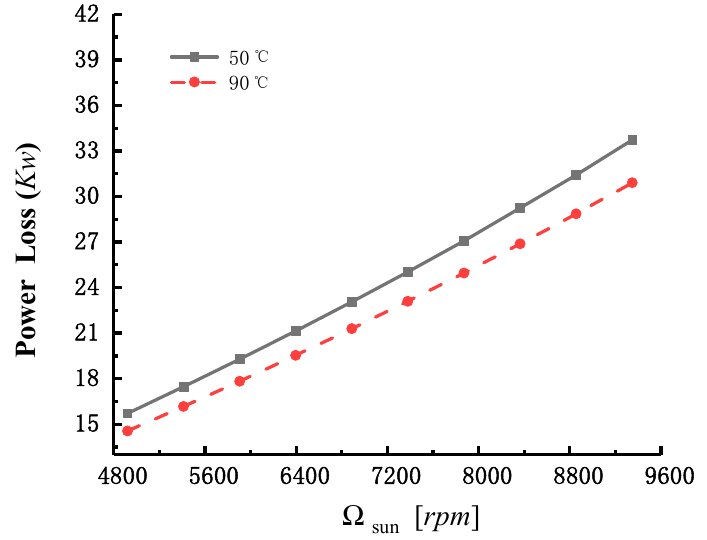
Figure 13. Comparison of power loss as functions of Ω sun at 50 °C and 90 °C.